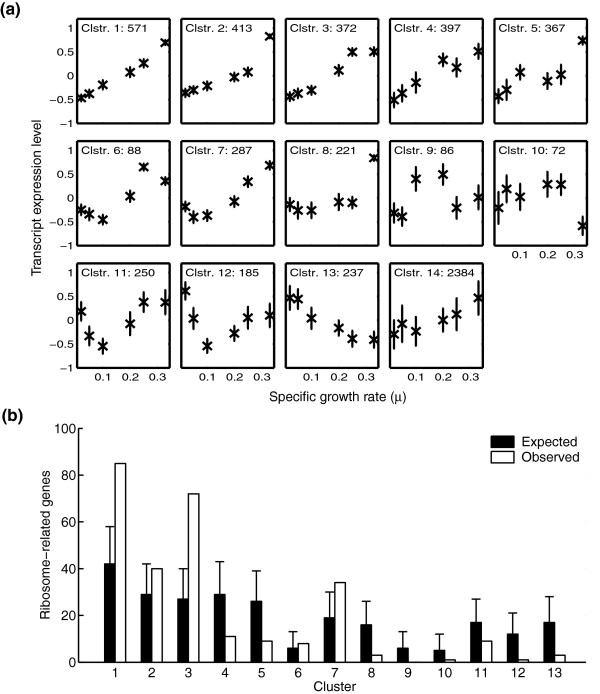
Clusters of genes that are coexpressed at specific growth rates from 0.02 to 0.33 per hour. (a) The transcript levels of differentially regulated genes are shown as transformed values between -1 and 1, where 0 indicates the average expression level over all six specific growth rates (μ = 0.02, 0.05, 0.1, 0.2, 0.25, and 0.33 per hour). The average transcript level within a cluster is indicated by the curve and the error bars give the standard deviation on the transcription profiles (clusters can be found in Additional data file 3). The 13 clusters originate from 27 clusters that were reduced manually (Additional data file 2). This was done by merging very similar clusters (clusters close in the dendrogram and discarding clusters that appeared to arise from experimental variation). Finally, ORFs that could not be assigned to a cluster with at least 80% probability (Pa < 0.20) were discarded and collected into a 'trash' cluster 14 together with the discarded clusters. (b) shows the expected distribution of ribosome related genes (black bars) and the actual distribution of ribosome related genes (white bars) in the 13 clusters.